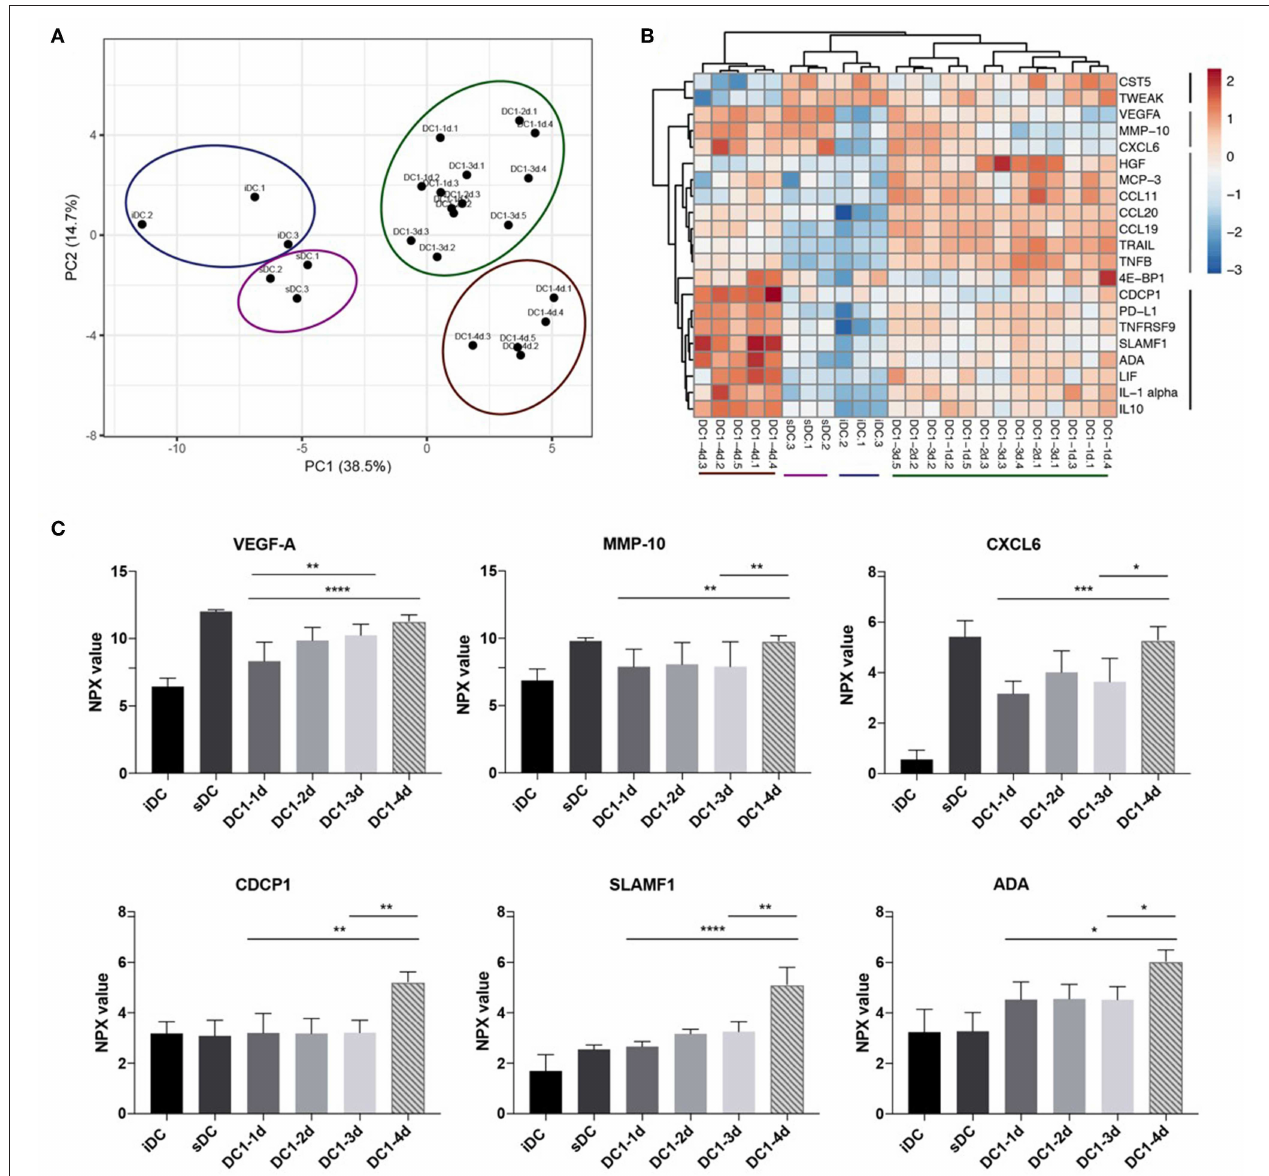
FIGURE 4 | Long-term exposure to inflammation induces differential cytokine patterns in dendritic cells. (A) Principle component analysis of 50 detectable proteins measured in culture supernatants from DCs activated with the DC1 activation cocktail (LPS and IFN γ ) for 1, 2, 3, or 4 days (DC1-1d, DC1-2d, DC1-3d, DC1-4d). Immature DCs (iDCs) and sDCs, stimulated with the gold standard activation cocktail (TNF α + IL-1 β + IL-6 + PGE 2 ) for 1 day (18h), were included for comparison. Supernatant from three-five donors was included in the analysis ( n = 5 for 1-, 3-, and 4-day activated DCs). (B) Dendrogram depicting hierarchal clustering and heat map analysis of normalized levels of 21 proteins found by two-way ANOVA to significantly differ between five matched samples from 1-, 3-, and 4-day activated DC1s. (C) Six proteins that besides IL-10 was also strongly upregulated in 4-day activated DC1s. Two-way ANOVA with Tukey’s post-hoc test was performed to compare DC1 groups where **** p ≤ 0.0001, *** p ≤ 0.001, ** p ≤ 0.01, * p ≤